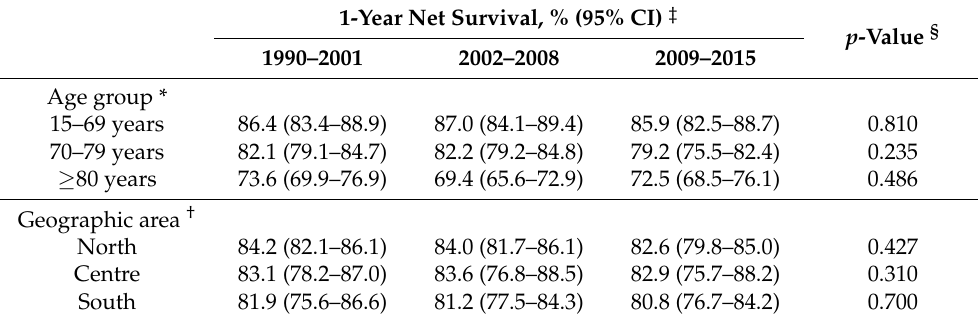
Table 3. Trend in 1-year net survival from vulvar squamous cell carcinoma by age group at diagnosis and geographic area. Italy, 1990–2015 (total resident female population 15,358,161 in